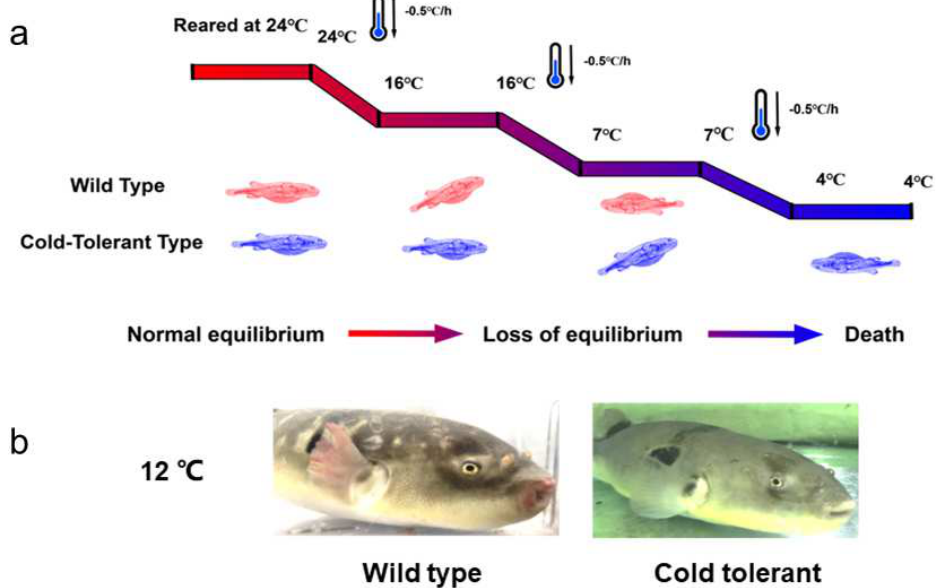
Figure 1. Phenotypic distribution of cold-tolerant fugu and the model of the cooling experiment. ( a )The temperature treatment model of the fugu cold stress experiment. ( b )The phenotypic changes of fugu under low-temperature treatment can be observed. The subcutaneous congestion and frostbite are obvious in wild-type fugu.